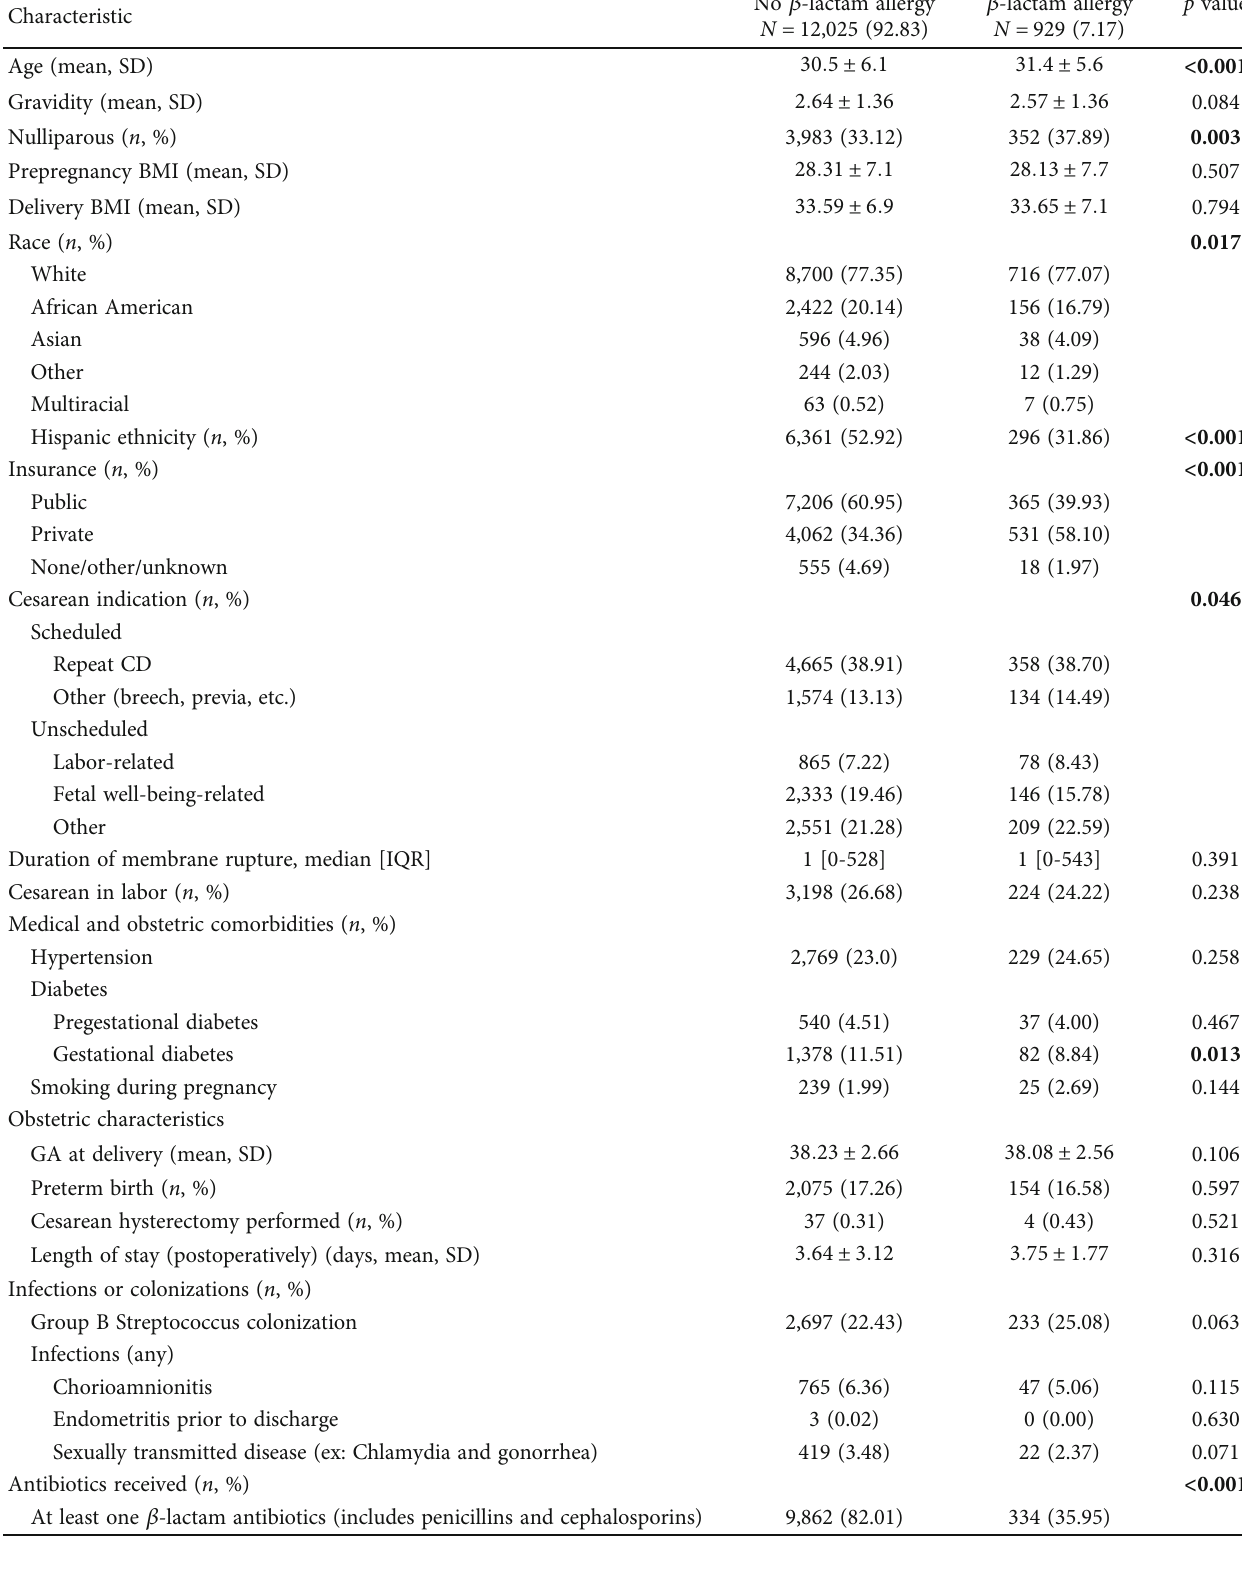
Table 1: Maternal demographics and obstetric characteristics for women with and without β -lactam allergy.